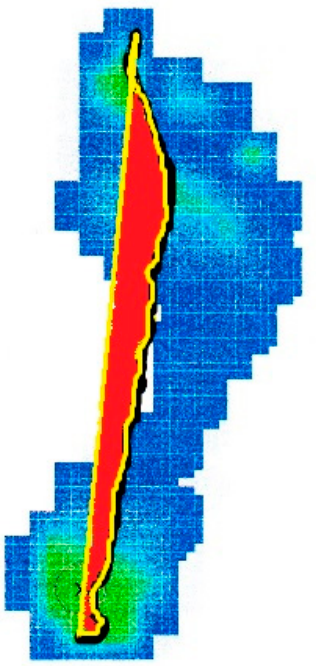
Figure 5. Percentage of the center of pressure locus area (red), defined like the ratio of the area encompassed by the center of pressure path (black, underlined above with yellow) and a line between the start and end points of the center of pressure path (straight yellow line) to the foot area.